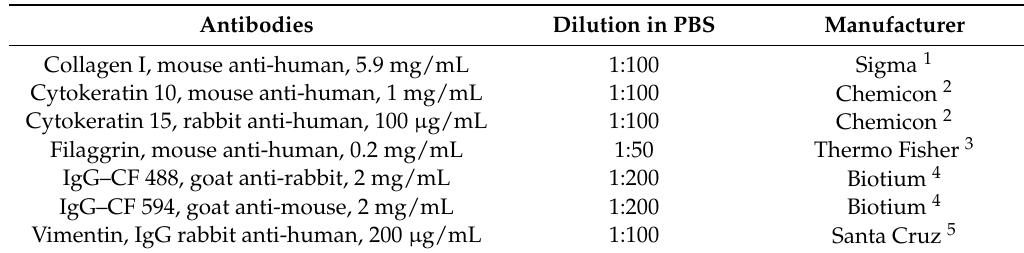
Table 1. List of antibodies used for immunofluorescence staining. Antibodies Dilution in PBS